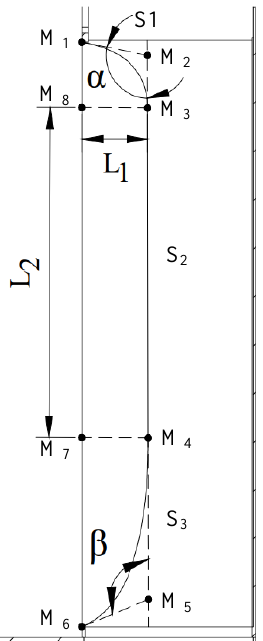
Figure 13. Parametric schematic diagram of guide leaf profile.